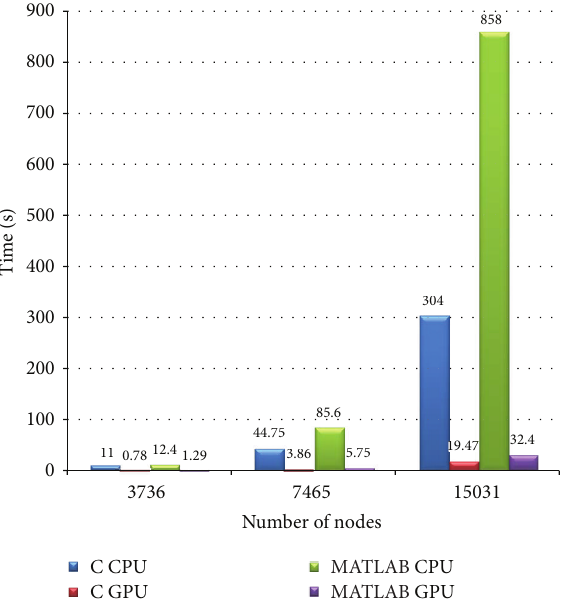
Figure 10: Execution time for an iteration on C CPU, C GPU, MATLAB CPU, and MATLAB GPU platforms for different mesh